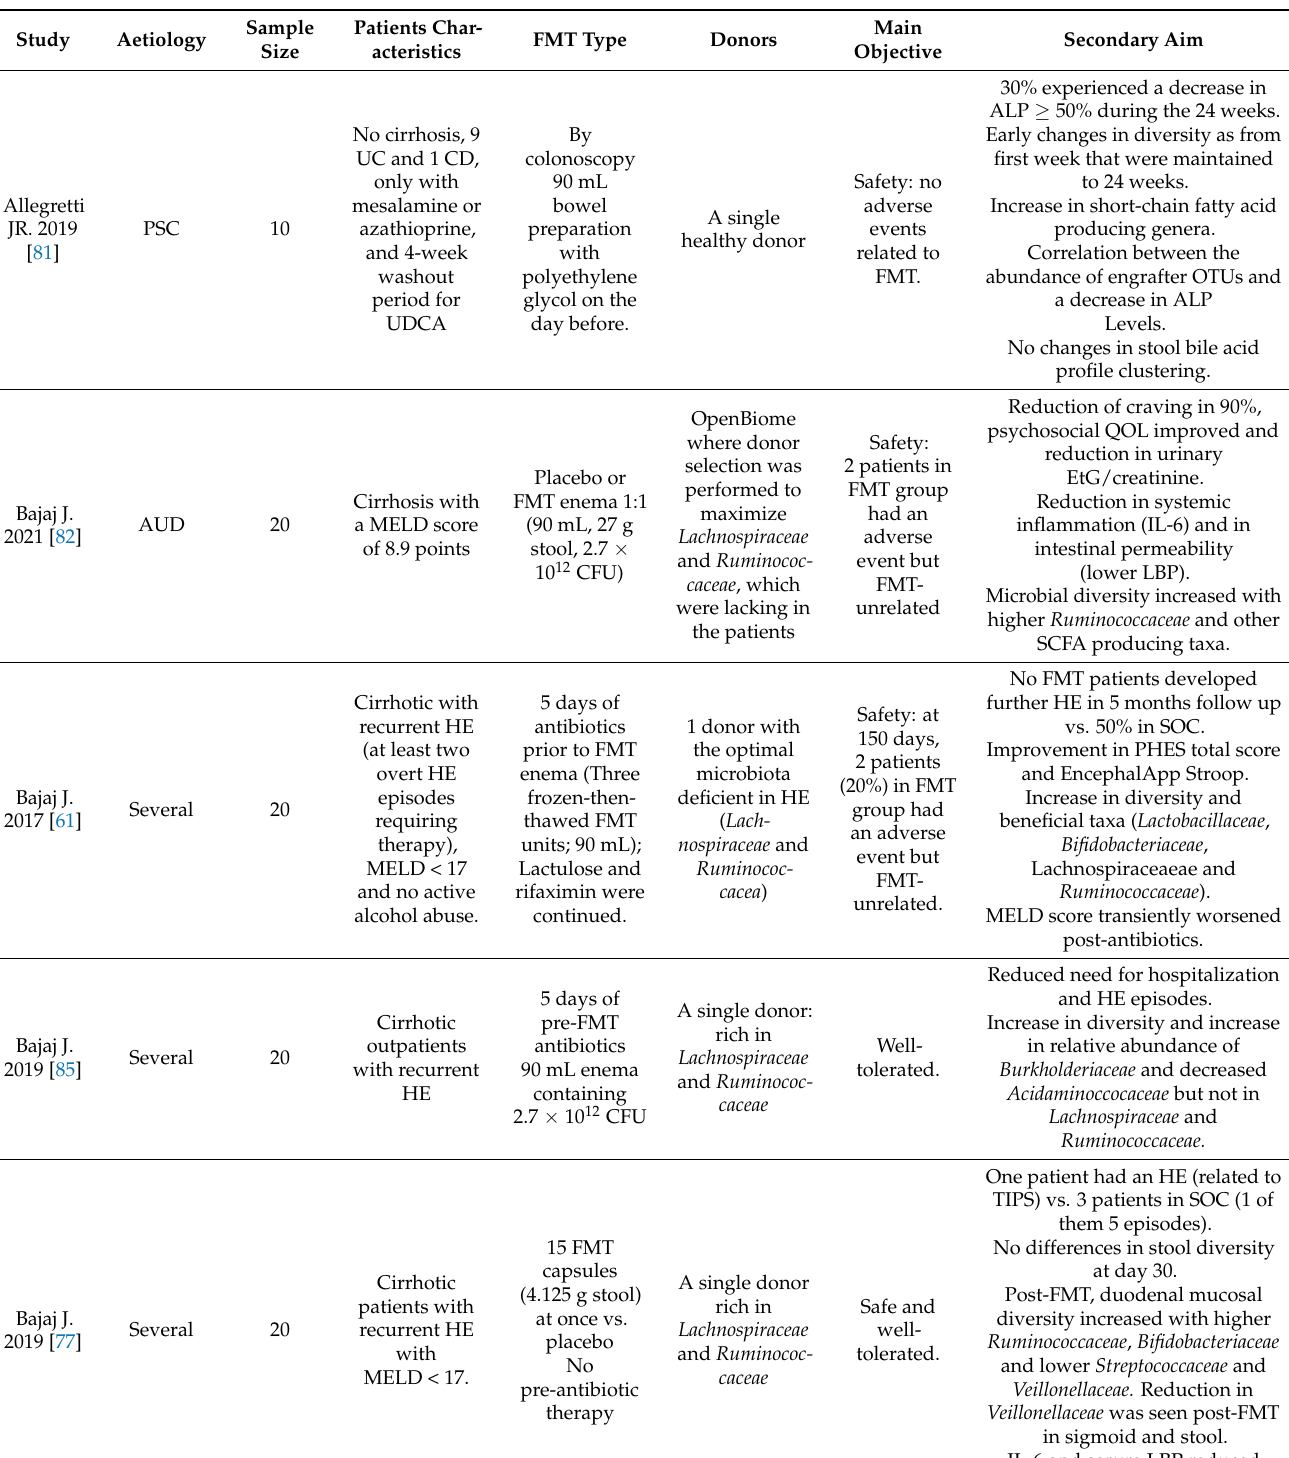
Table 2. Summary of studies about faecal microbiota transplantation (FMT) in chronic liver dis- eases